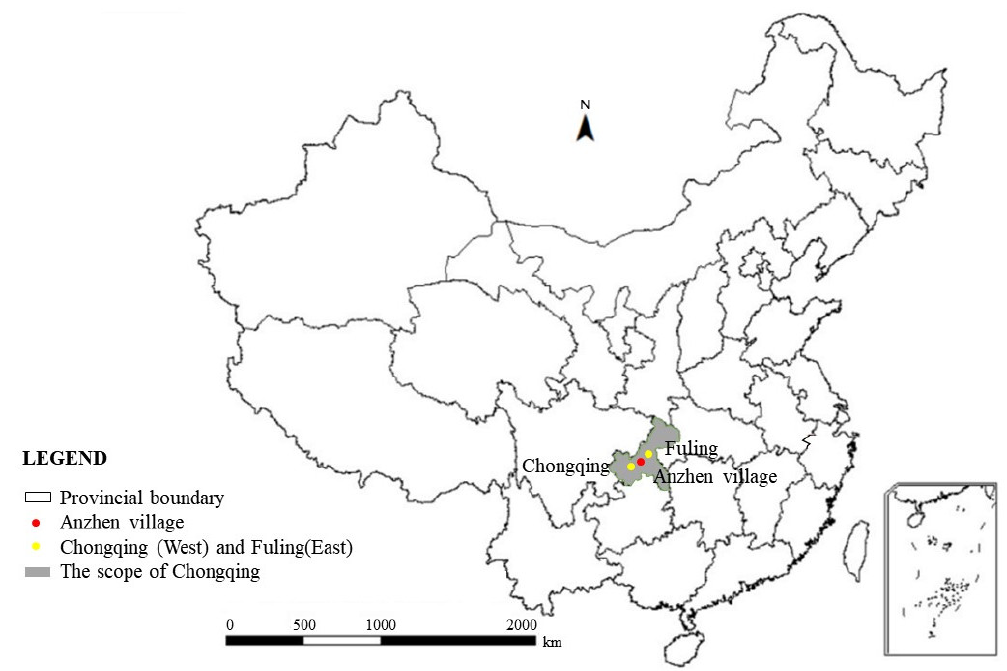
Figure 3. Anzhen Village’s location in Chongqing, China (source: Drawn by the author).